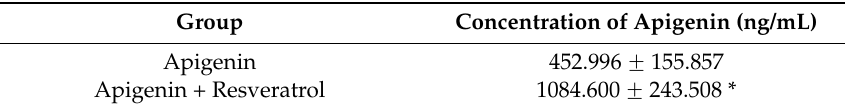
Table 1. Mean concentration of apigenin in plasma after oral administration of apigenin and/or resveratrol to mice. Data were represented with mean ˘ SEM. ( n = 5).